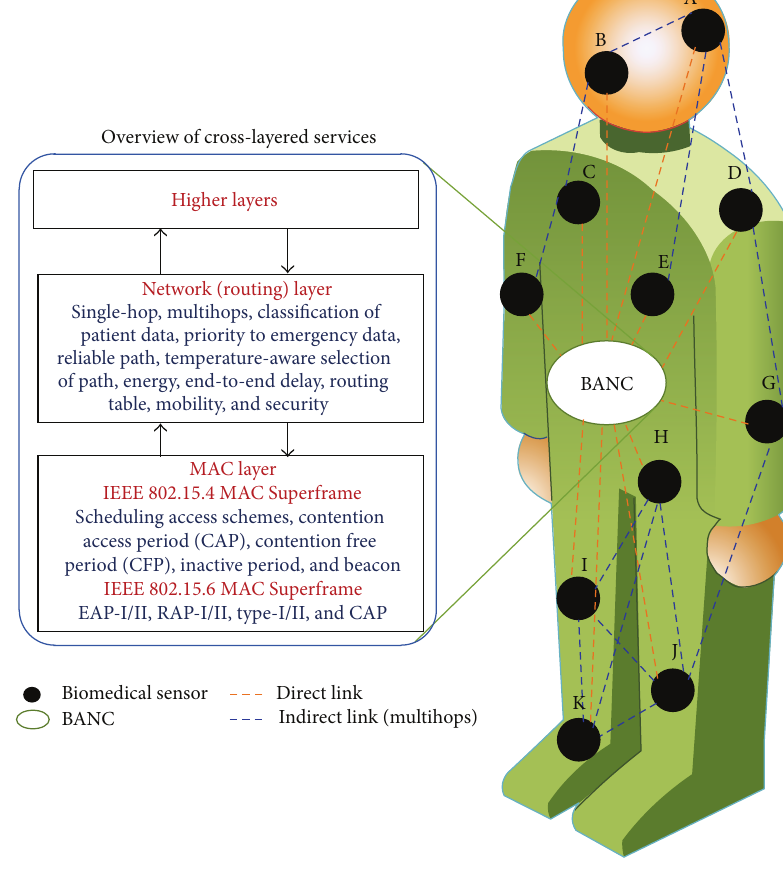
Figure 5: Cross-layers architecture in